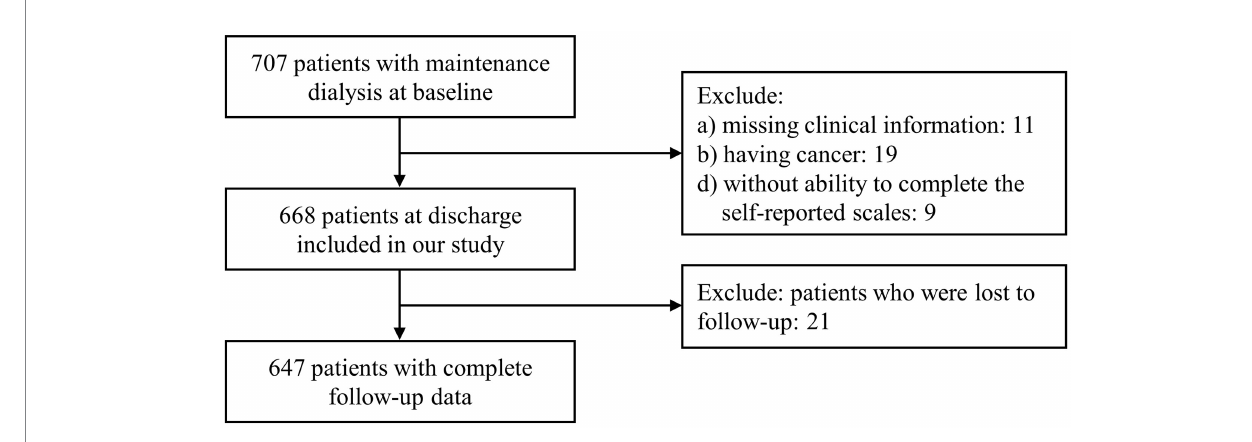
FIGURE 1 Inclusion